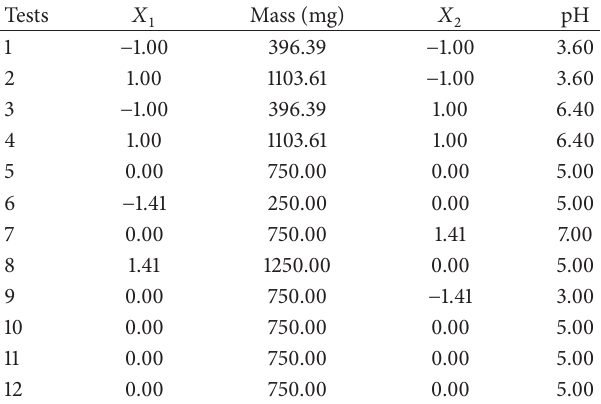
Table 1: CCRD planning matrix (coded and real